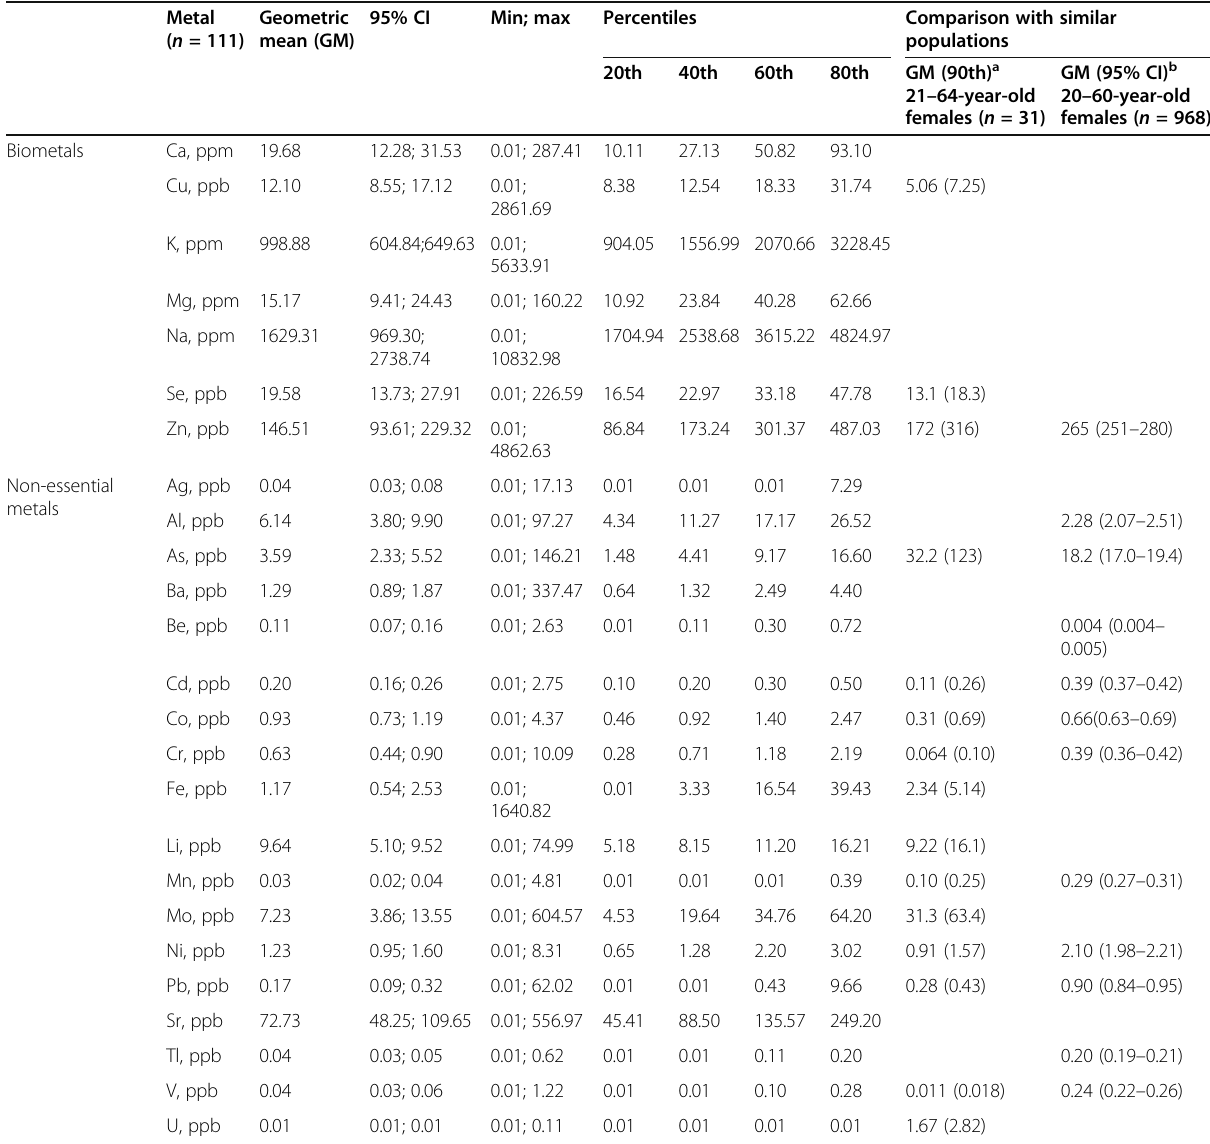
Table 2 Internal dose of metals in the study population Metal Geometric 95% CI Min; max ( n = 111) mean (GM)